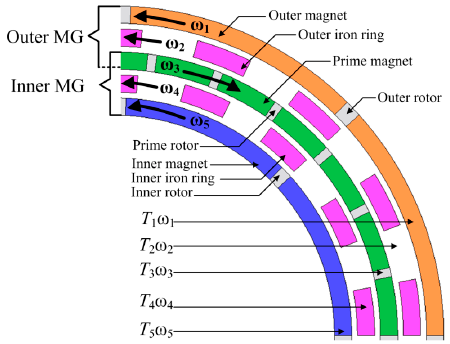
Figure 4. Mechanical power flow distribution in the triple-rotor magnetic gear.